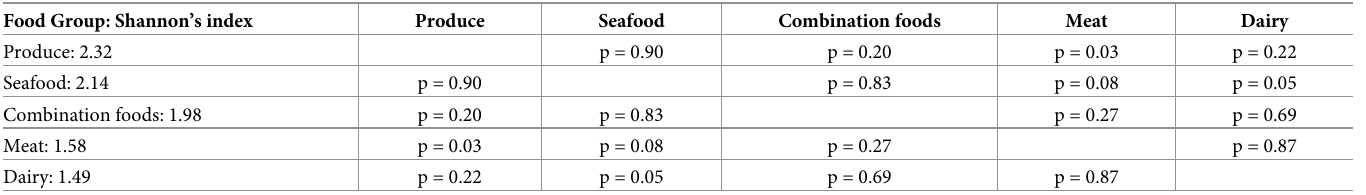
Table 2. Pairwise comparisons of isolates per food group in the diversity of clonal complexes a